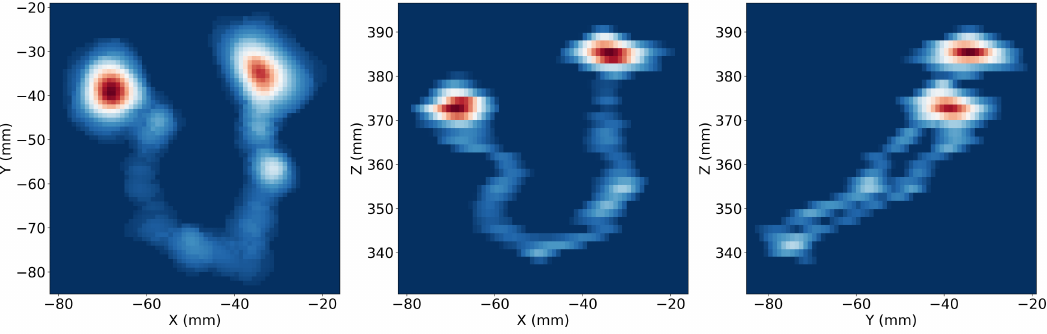
Figure 16 . Deconvolved 2.0 MeV 2 νββ candidate obtained during the current data taking of